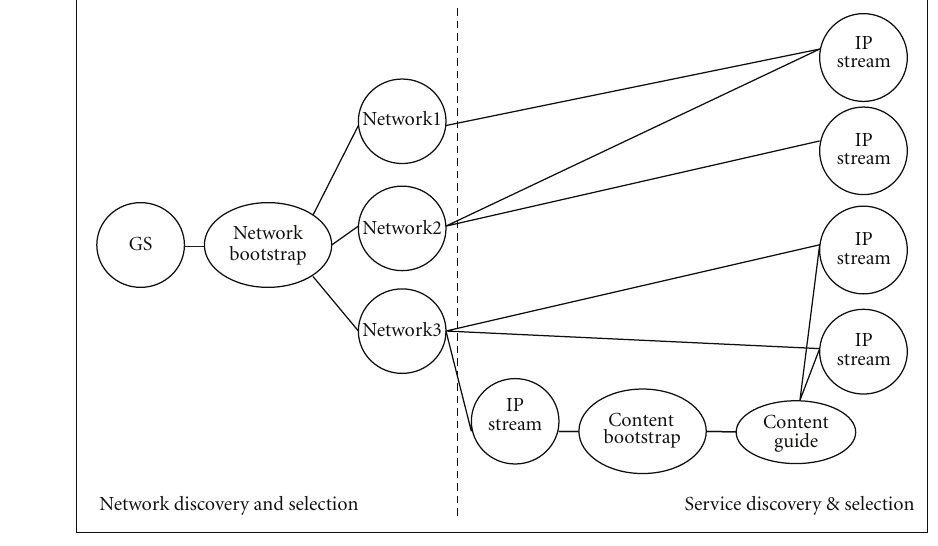
Figure 2: ND&S and SD&S procedures.